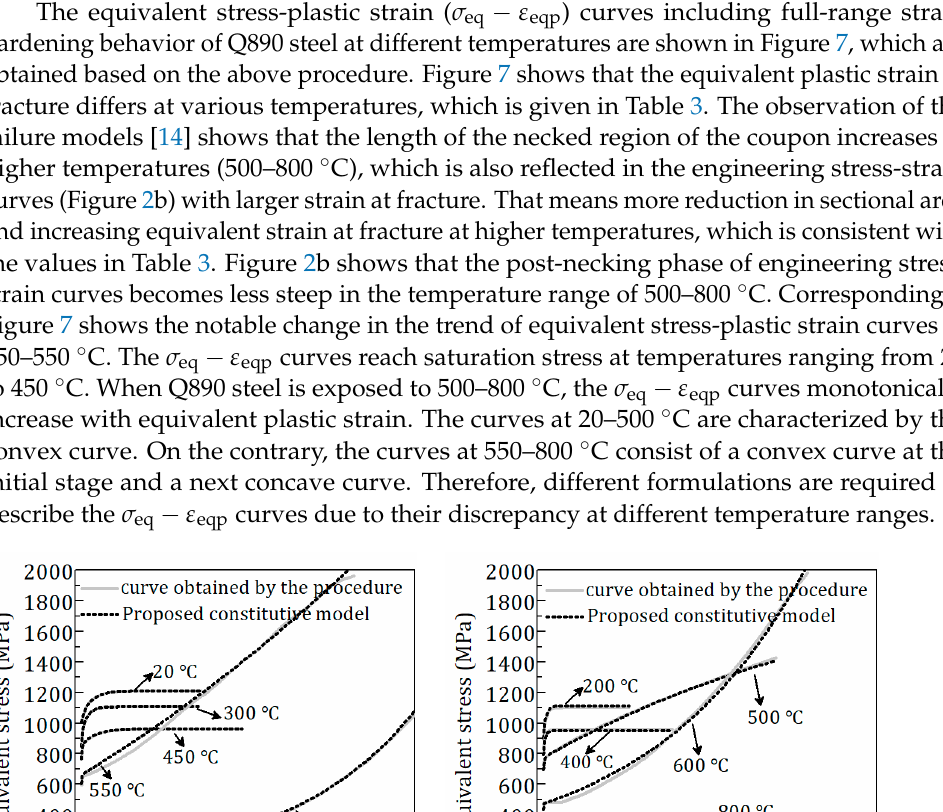
Figure 6. Axisymmetric finite element model of uniaxial tensile tests: ( a ) Boundary conditions; ( b ) Mesh convergence analysis; ( c ) Mesh (size: 0.125 mm).